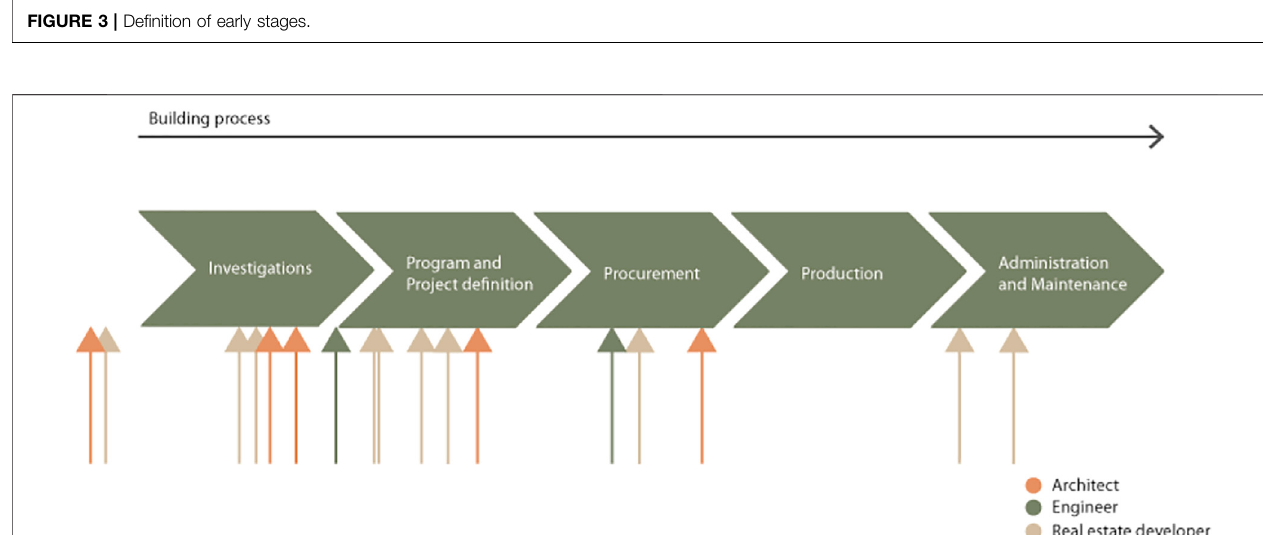
Frontiers in Built Environment |